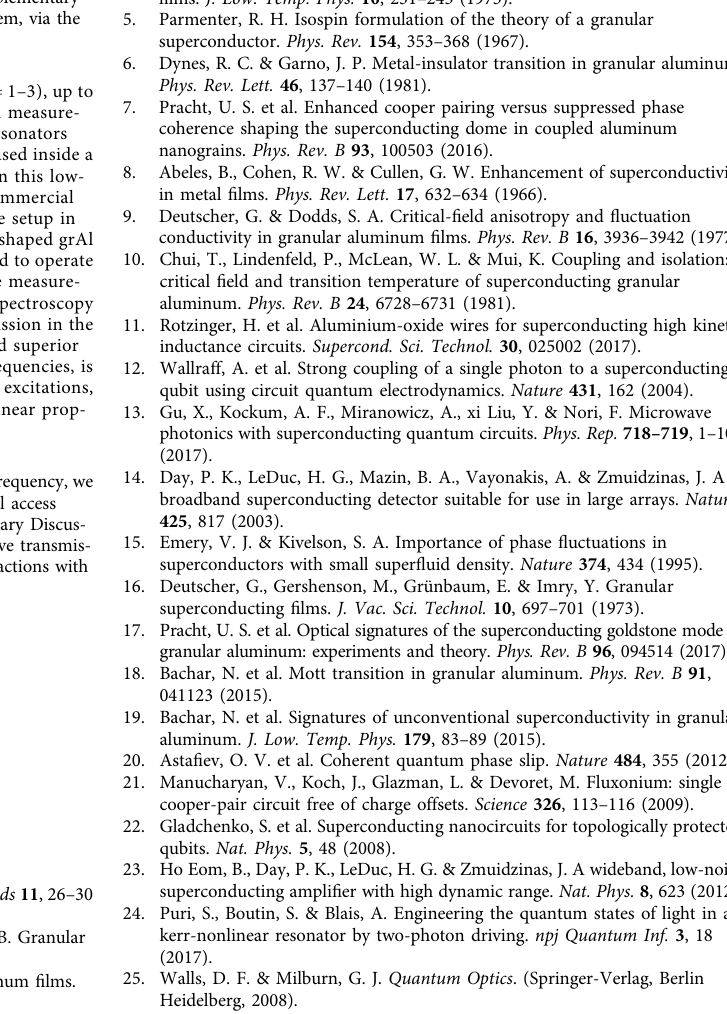
Fig. 5 Measured grAl self-Kerr nonlinearity. The measured self-Kerr coef fi cients of 14 grAl samples are plotted versus f 2 frequency of the fi rst-mode, j c is the critical current density, and V grAl is the sample volume, with values listed for each sample in the legend. Hilbert-shaped resonator samples are represented in blue, stripline samples in green, and Al-shunted stripline resonators in red. The error bars for the blue points show the standard deviation of the measured K 11 for nominally identical resonators. In the legend, the samples are listed in decreasing K 11 order, within each group. The blue up-oriented triangle corresponds to sample grAl#2 (highlighted in blue), and the green circle corresponds to grAl#1 (highlighted in green). The black line shows the calculated self-Kerr from Eq. (4), for a grain size a = 4 nm, which includes the 1 nm thickness of the aluminum oxide barrier. We estimate the main error source to be the photon number calibration, which can only be estimated within a factor of Methods Experimental apparatus . The dispersion relation for grAl resonators spans up to ~100GHz. To cover this wide frequency range, we employ two complementary measurement setups, and we use the fi rst mode as a link between them, via the cross-Kerr effect. Low-frequency setup . The low-frequency part of the spectrum ( n = 1 – 3), up to 20 GHz, is measured using microwave transmission and re fl ection measure- ments in a standard cQED setup 12 (Fig. 2b). The grAl stripline resonators (Fig. 2a) are mounted in a 3D waveguide (WG) sample holder, housed inside a